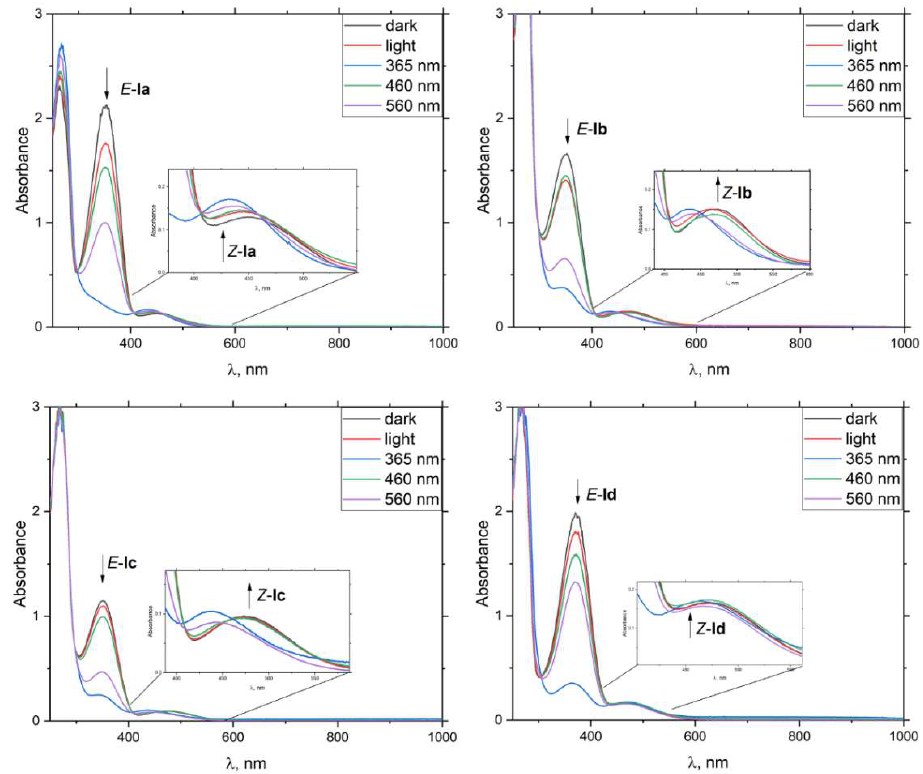
Figure 6. UV/Vis spectra of the studied materials measured in dark (black), at ambient light (red), UV-light (365 nm, blue) and two visible light wavelengths (460 nm, green) and (560 nm, purple). In order to determine the exact ( E )/( Z ) ratio after irradiation with various light sources, the PSS of reversible photochemical switching between the ( E ) and ( Z ) isomers were established with 1 H NMR studies (Table 2). In all cases, UV light (365 nm) generated the higher ratio of ( Z ) isomer in comparison with visible green light (560 nm). The process of inverse isomerization (from ( Z ) and ( E )) is possible upon irradiation with blue visible light (460 nm). The best photo-response and switchability was shown in the fluorinated (Ia) and chlorinated (Ib) derivatives, while the larger excesses of ( Z ) formed in PSS 365 and PSS 560 . The inverse process of isomerization to the ( E ) configuration was effective How- ever, the bromo- and methyl-substituted compounds Ic and Id, respectively, exhibited higher ( Z )/( E ) ratios than Ia and Ib. Table 2. Ratio of ( E ) and ( Z ) isomers in various PSS states in deuterochloroform solution at room temperature.